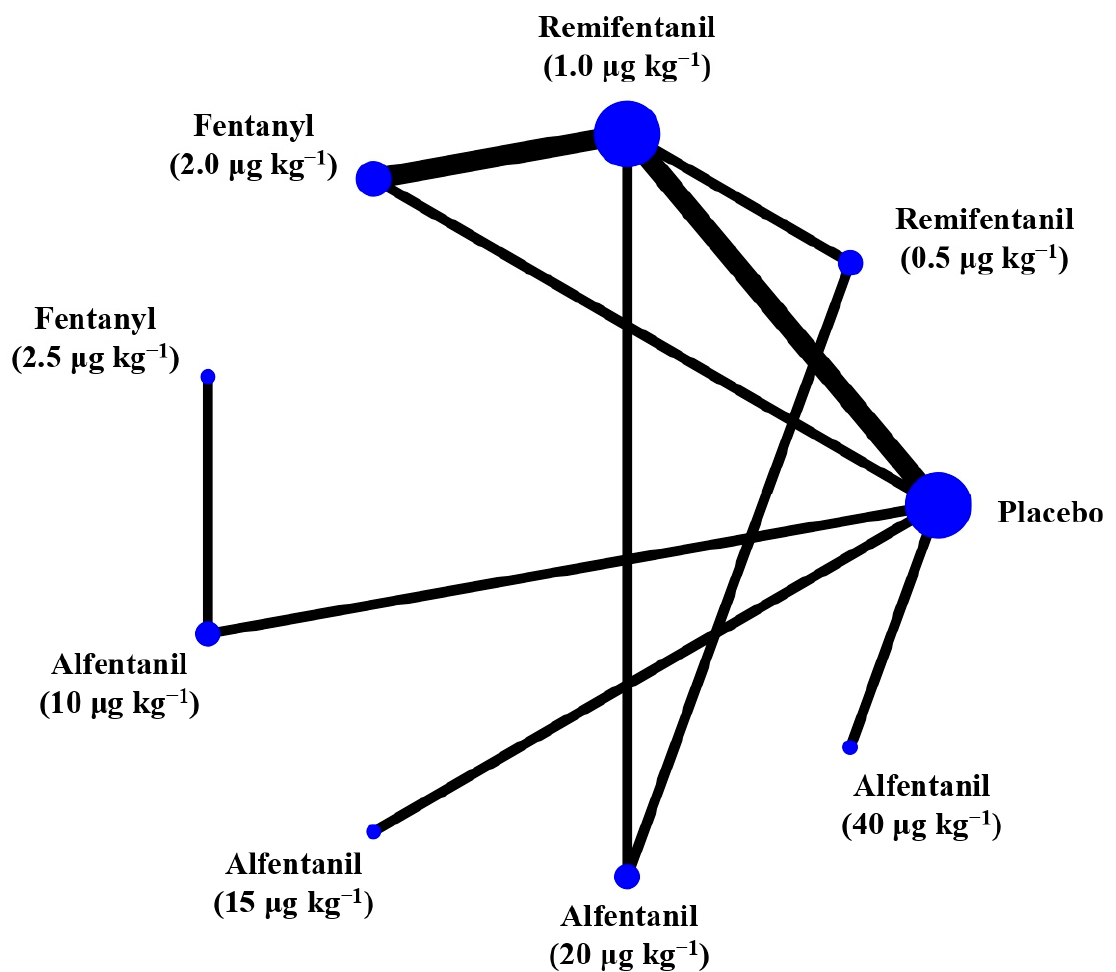
Figure 2. The network treatment comparisons for studies investigating the effects of short-acting opioids on intraocular pressure measured after endotracheal intubation. Each node represents a treatment, and the size of which corresponds to the number of patients studied with each treatment. Treatments that were compared directly are joined with a line, the thickness of which corresponded to the number of trials that assessed the comparisons.